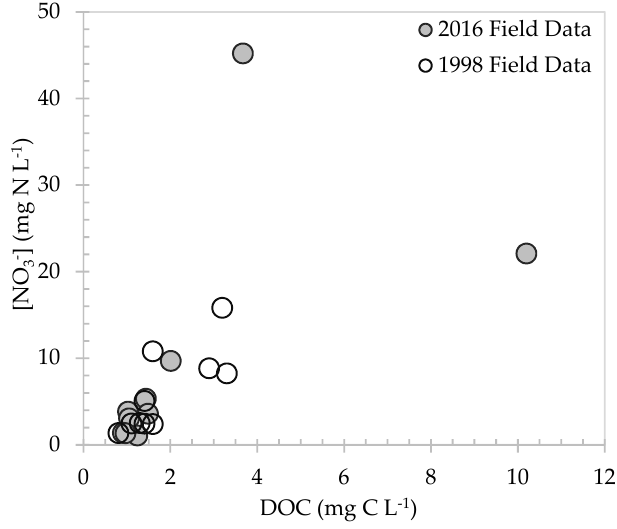
Figure A2. Comparison of [NO 3 − ] in 2016 and 1998 to dissolved organic carbon (DOC). Large [NO 3 − ] and DOC at Well 1G ‐ S are consistent with isotopes indicating high organic nitrogen source.